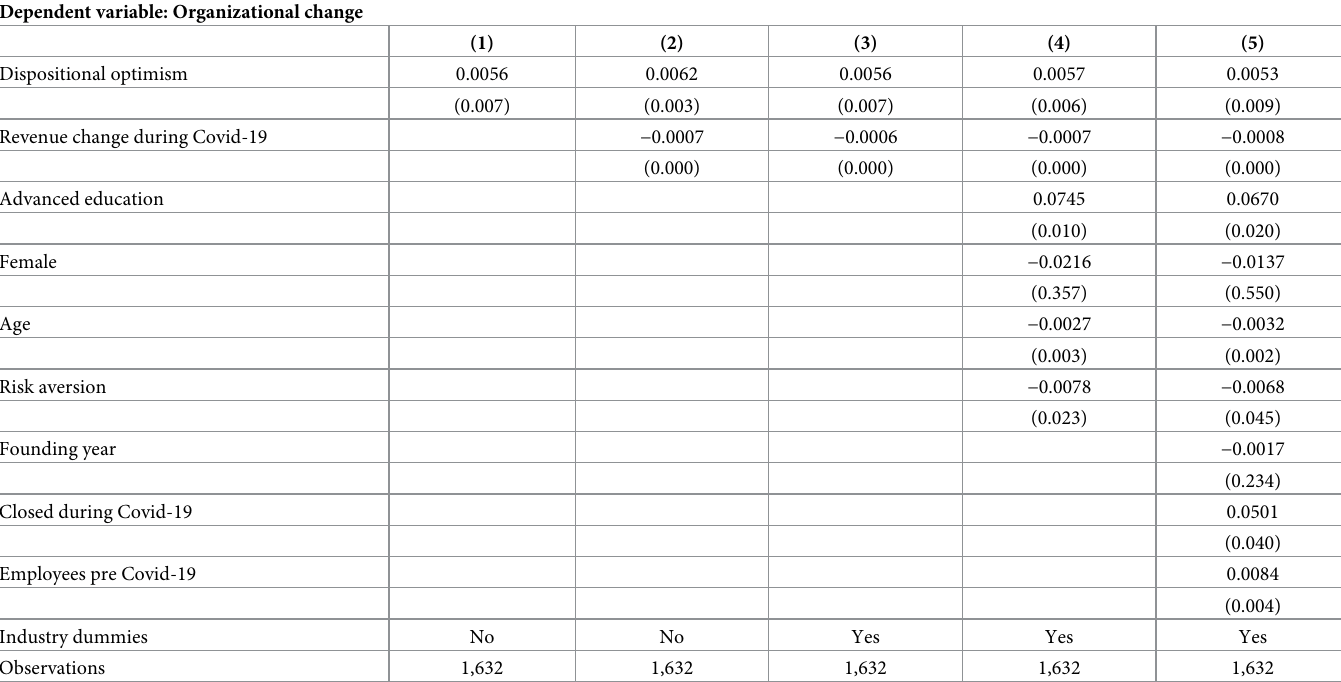
Table 2. Optimism and organizational change during the Covid-19